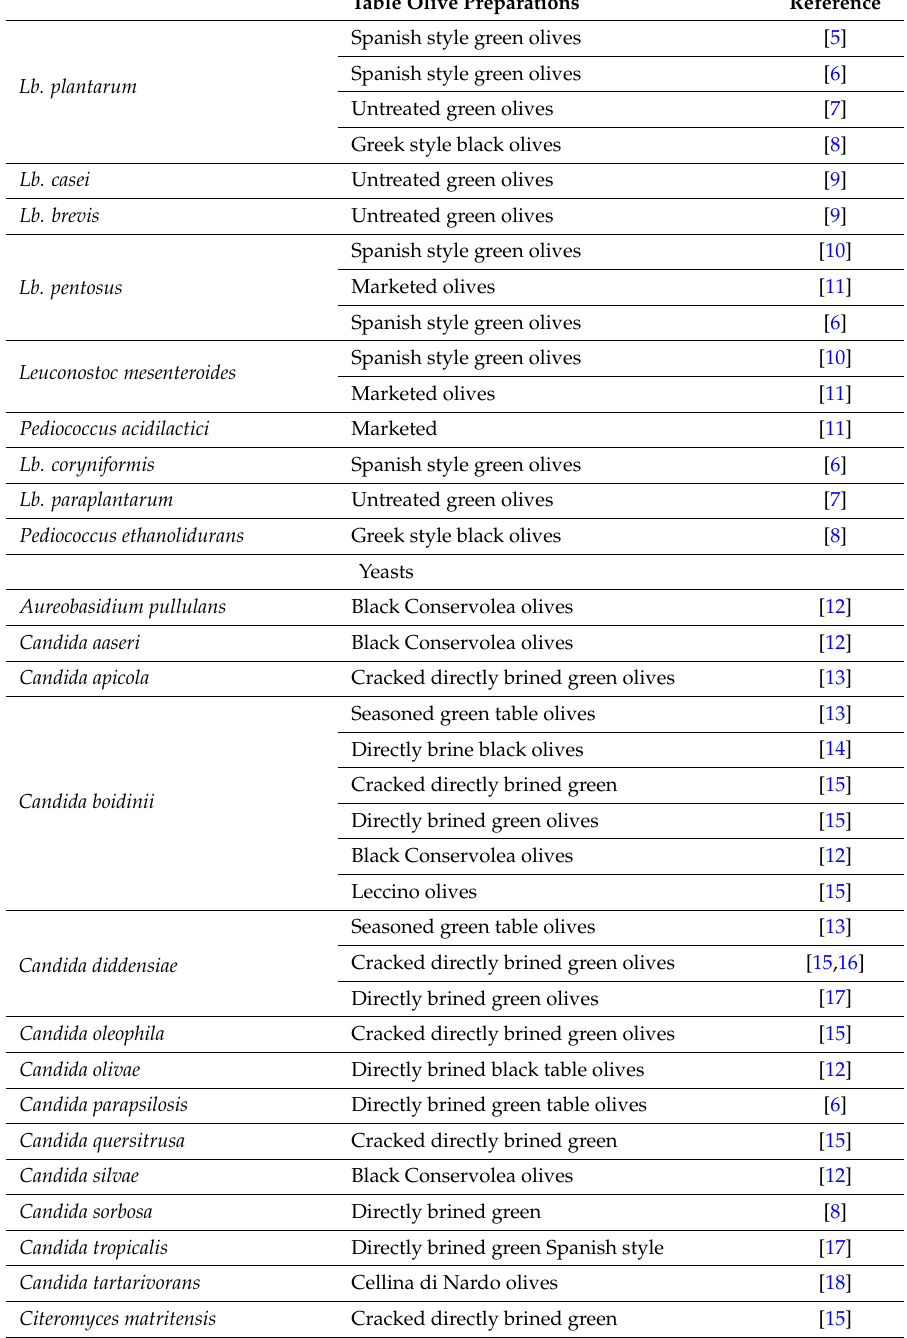
Table 1. Lactic acid bacteria and yeasts isolated from different table olive fermentation processing. Table Olive Preparations